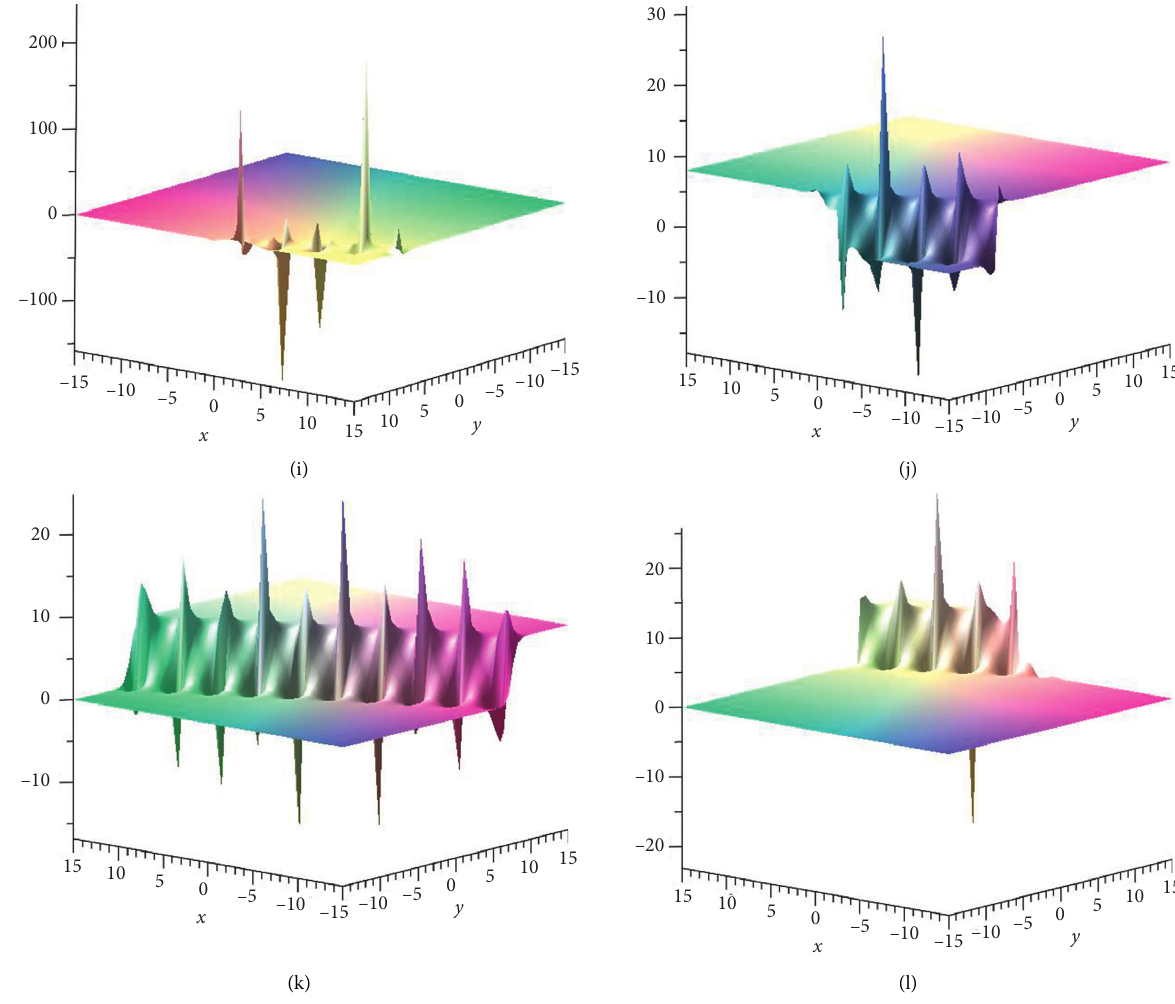
Figure 3: The breather solution u of equation (1) with the parameter selections m � 2 , p � 0 , k � 2 , δ